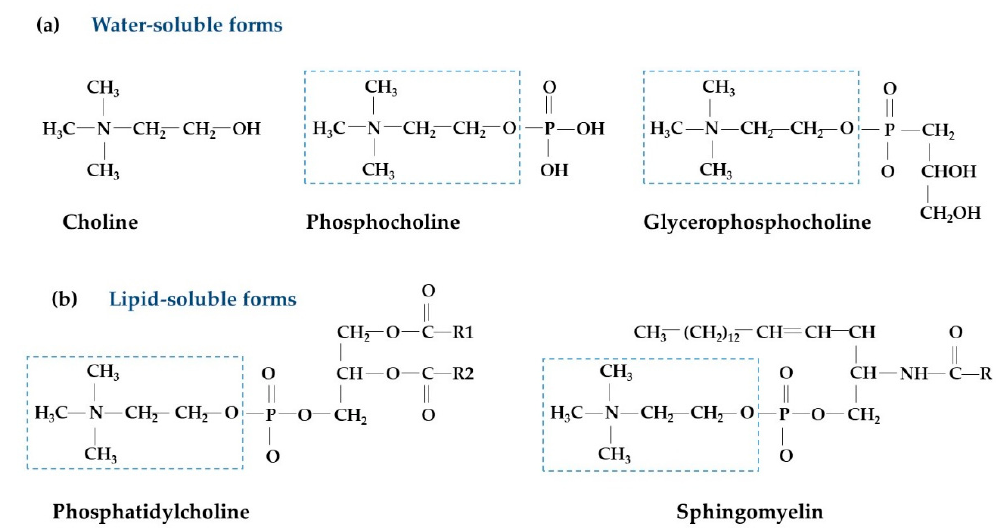
Figure 1. Structures of different choline forms: ( a ) Water-soluble forms; ( b ) lipid-soluble forms. Dashed box indicates free choline, R represents a fatty acid chain.